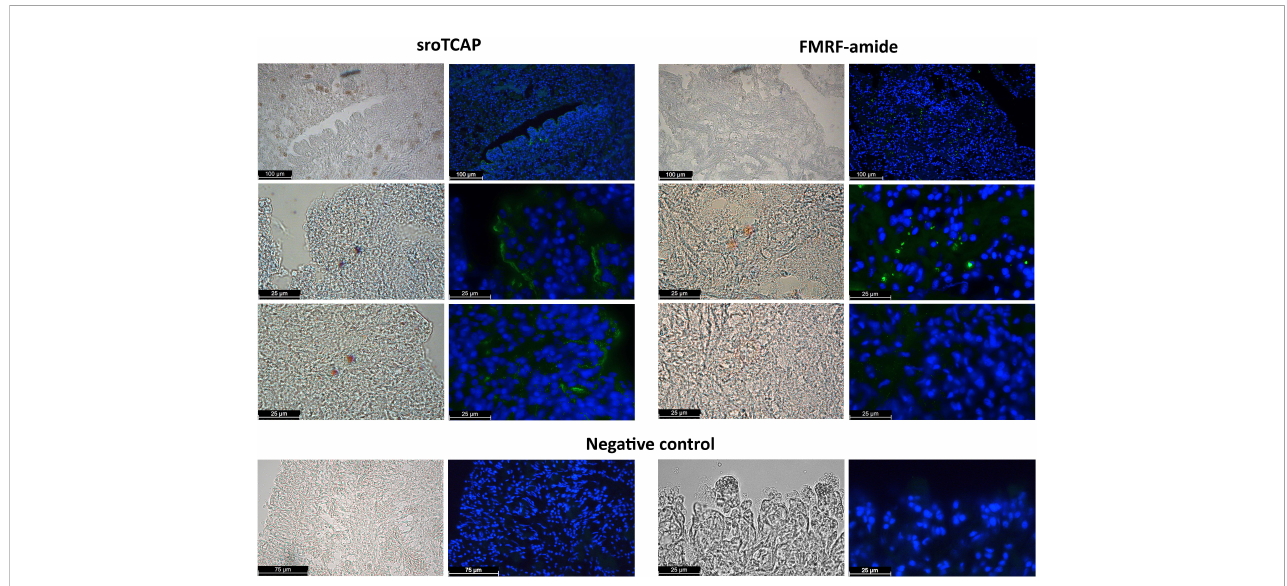
FIGURE 1 Immunohistochemistry of fi xed SRO heart sections showing immunoreactivity using anti-TCAP antibodies (green) and anti-FMRF (green). Negative controls, preadsorbed antibodies. DAPI stain shows cell nucleus in blue. Scale bars 25, 75 and 100